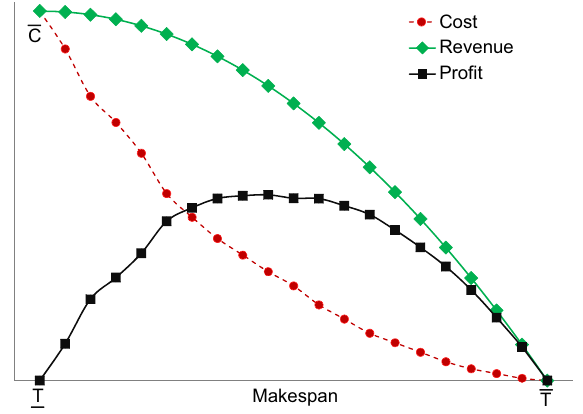
Fig. 5 Relationship between makespan, overtime cost, revenue and